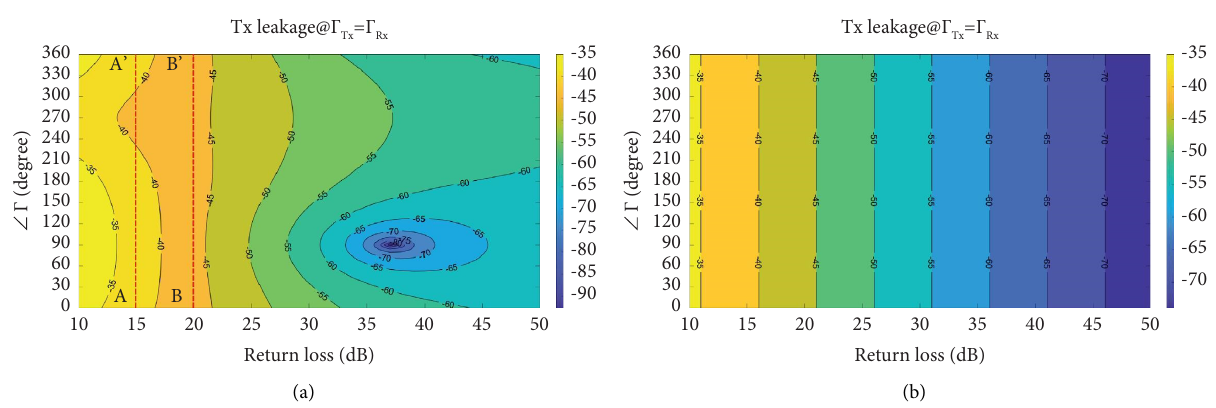
Figure 7: Tx leakage levels against the refection coefcients of the Tx and Rx antennas with Γ equation